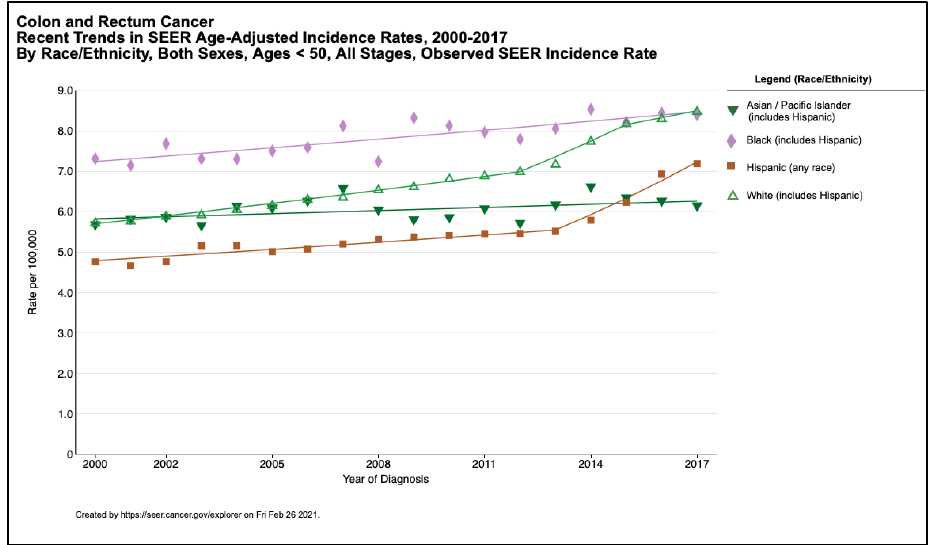
Figure 2. Observed incidence rates of colorectal cancer by race/ethnicity, both sexes, ages 20–49 years, United States, 2000–2017 from the SEER registry [39].